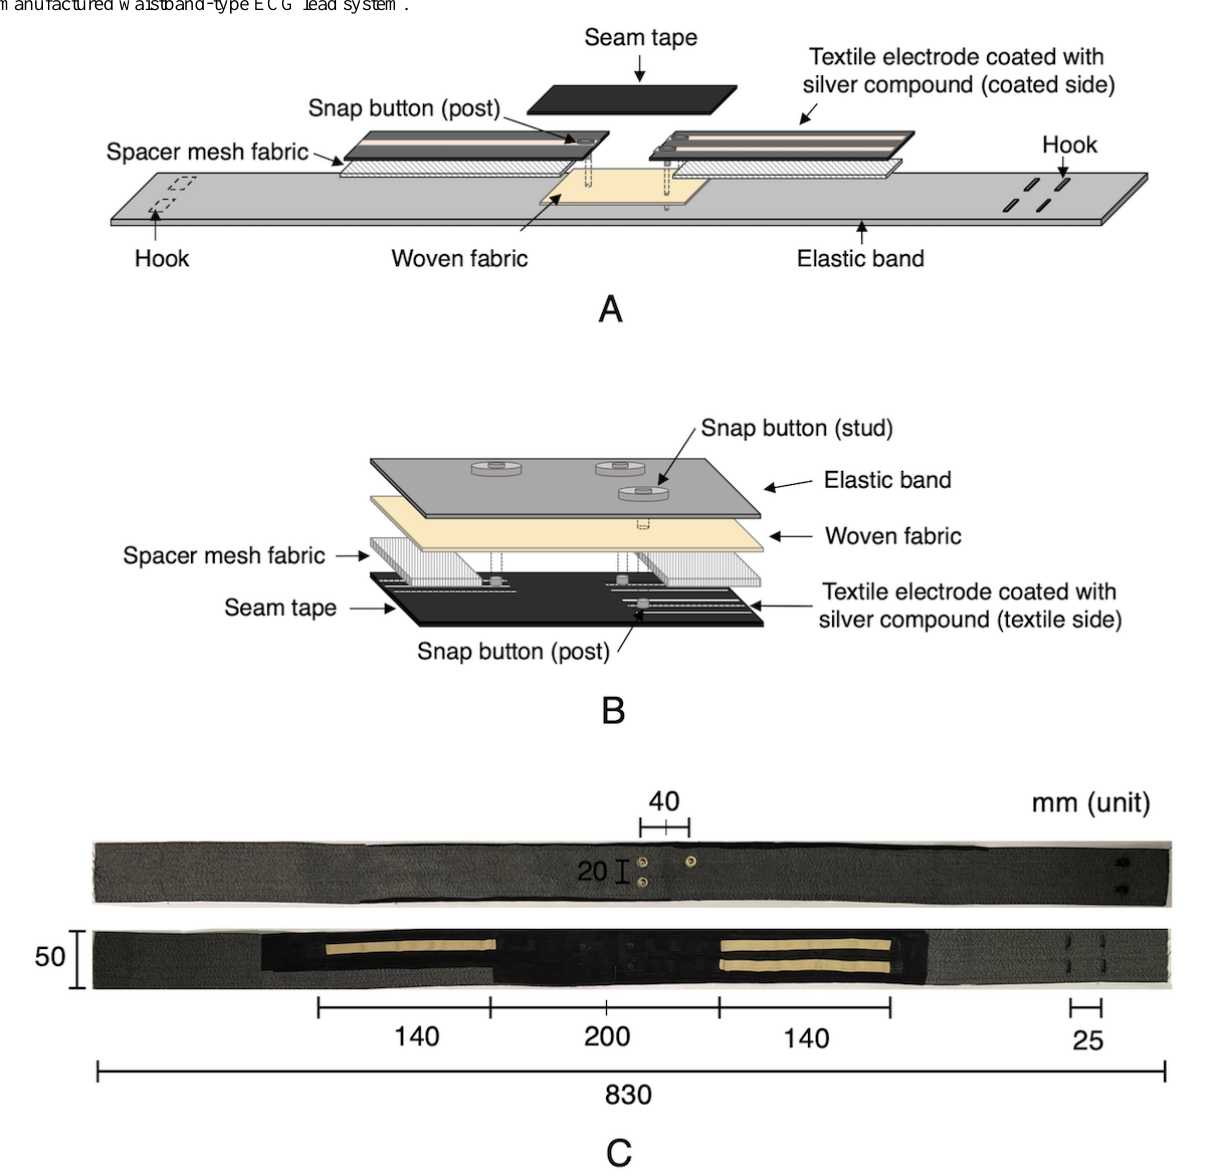
Figure 3. Waistband-type electrocardiogram (ECG) lead system using knitted textile electrodes. A. Configuration diagram of waistband for ECG measurement. B. Configuration diagram of snap button for connection between knitted textile electrode and ECG measurement device. C. Appearance of manufactured waistband-type ECG lead